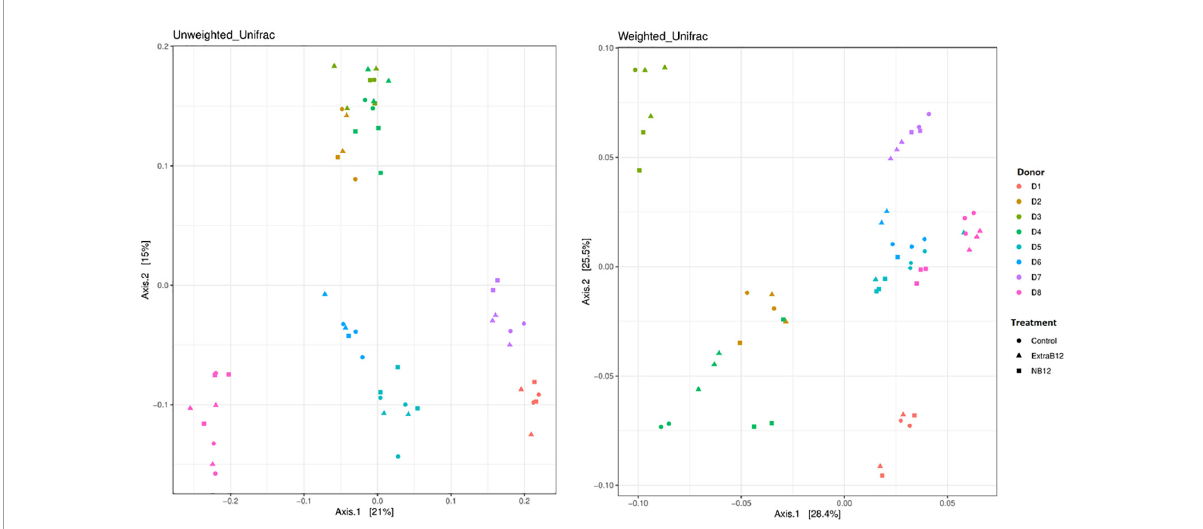
FIGURE3 Principal-coordinate analysis plots (PCoA) of unweighted and weighted Unifrac distance matrices of batch fermentation samples of eight microbiota (D1 to D8) after 24 h incubation in different treatments media (Control, NB12, and ExtraB12). The symbols in the PCoA analysis represent the treatments while the colors represent the